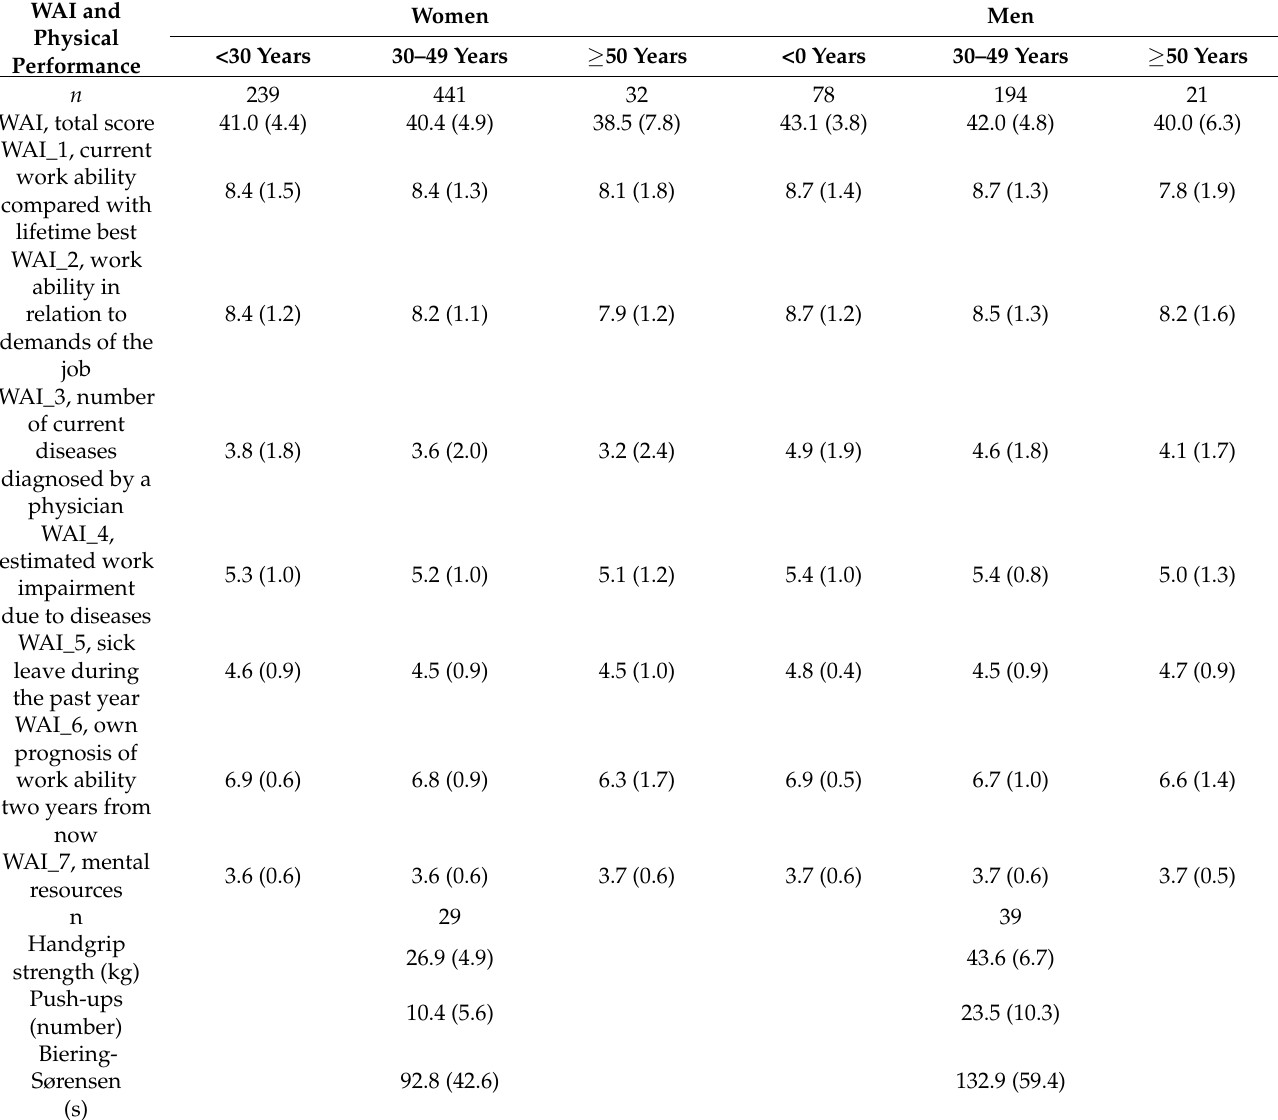
Table 2. Normative values of work ability (total score and subscales 1–7) as well as physical performance. WAI